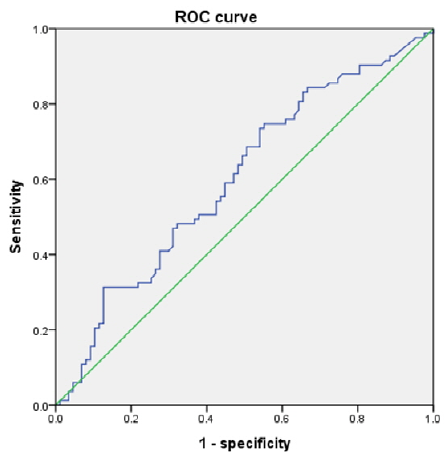
Figure 3. LARD ROC Figure 3. LARD ROC curve.